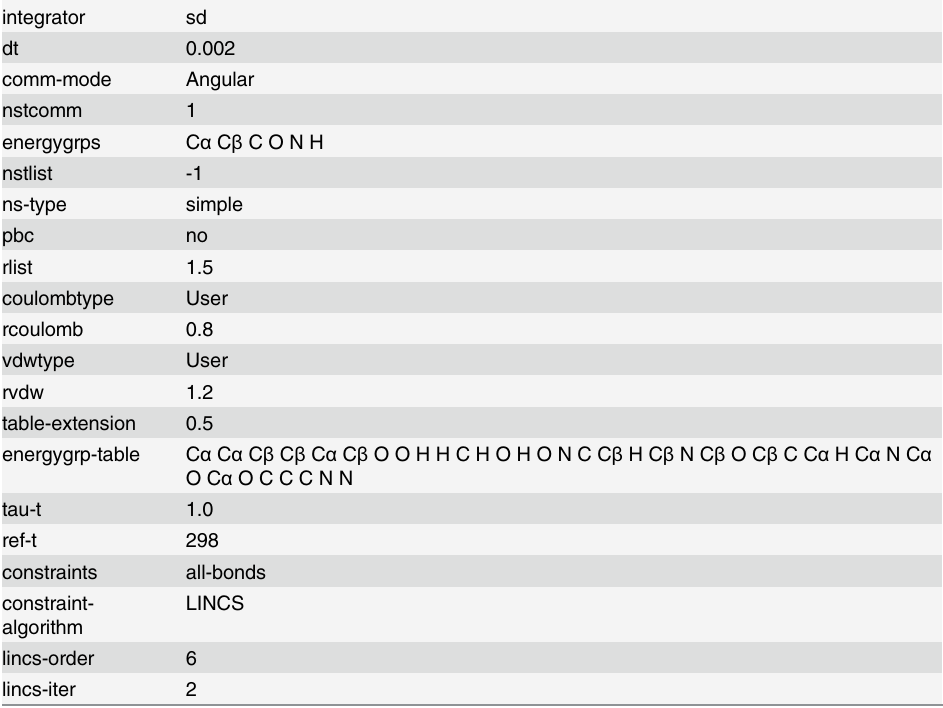
table-extension 0.5